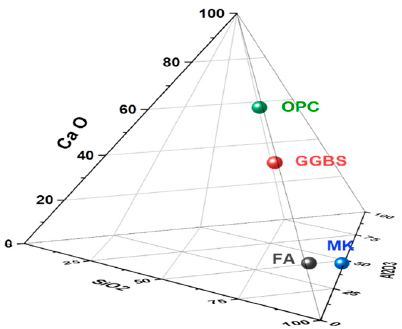
Figure 2. 3D Ternary Diagram of Aluminosilicate binders.